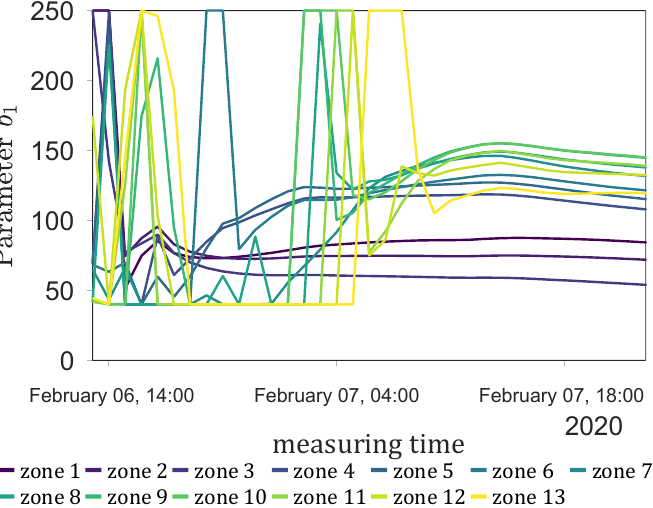
Figure 10. Temporal profile of parameter b 1 for sigmoid estimation of a melting process in